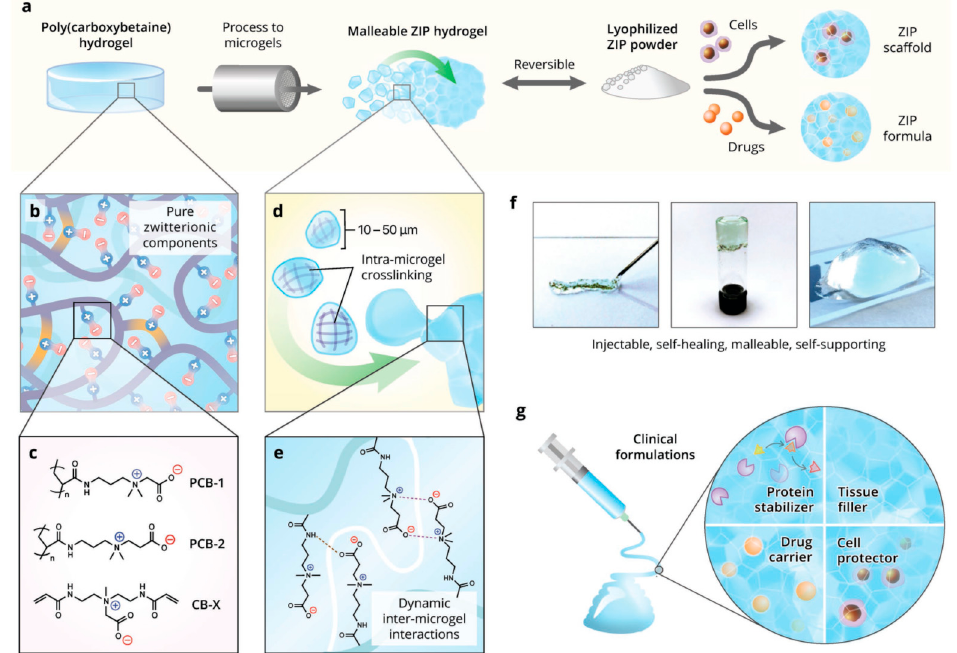
Figure 2. Production, properties, and applications of zwitterionic injectable pellet (ZIP) hydrogels. ( a ) Overview schematic showing the production of viscoelastic ZIP gels, which can be lyophilized for simple formulation and mixed with cells or therapeutics. ( b ) Hydrogel components are purely zwitterionic, consisting of ( c ) carboxybetaine acrylamide polymers (PCB-1 or PCB-2) with carboxybetaine diacrylamide crosslinker (CB-X). ( d ) Covalent crosslinks inside each microgel enable bulk support and elasticity. ( e ) Dynamic zwitterionic fusion interactions enable reconstruction of microgels into new viscoelastic ZIP material. ( f ) ZIP gels can be injected through needles, self-heal, and retain their shape. ( g ) Applications of ZIP gels include injectable soft tissue fillers, therapeutic carriers, and cell scaffolds for growth and protected injection [99]. (Reproduced with permission from Wiley.) Table 3. Microgels and their applications as cell carrier.